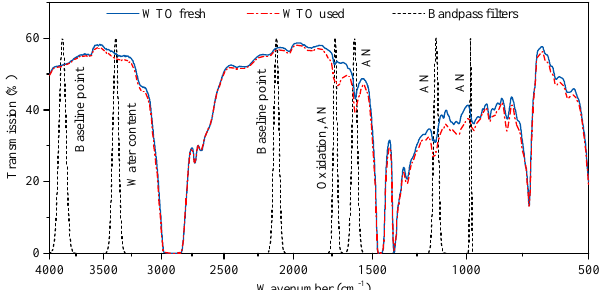
Figure 5. Transmission spectrum of one fresh and one used WTO sample and illustration of the optical bandpass filters selected for the non-dispersive infrared (NDIR) sensor